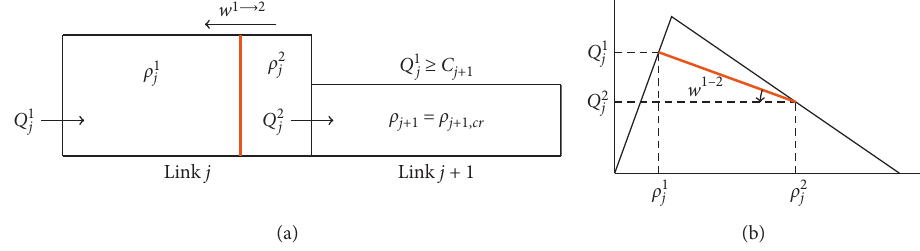
Figure 8: Backward moving shock wave created by reduced capacity on link j +